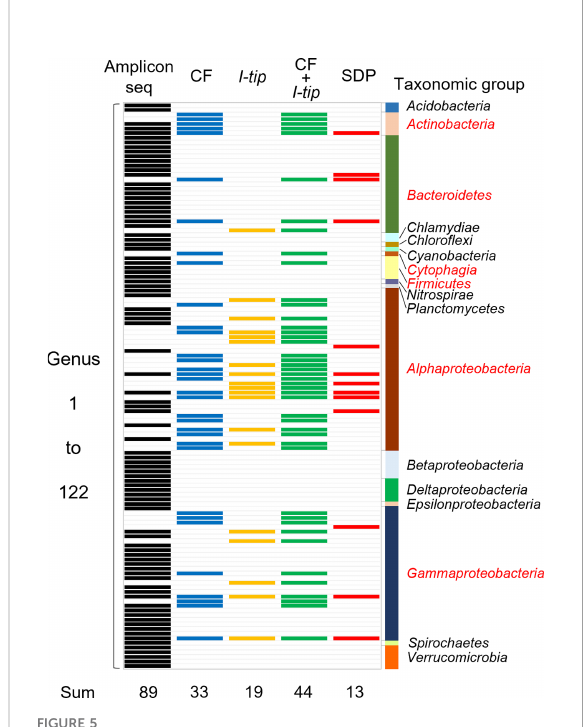
FIGURE 5 Band chart showing the comparison of microbial community compositions at the genera level among the sponge microbial community (amplicon sequencing data), isolates from CF, I-tip, and SDP cultivations. A total of 122 genera were detected from culture-independent and dependent approaches. Numbers at the bottom indicate number of genera detected with each method. Those are 89 from the amplicon sequencing data (black-colored bands), 33 from CF isolates (blue-colored bands), 19 from I-tip isolates (yellow-colored bands), 44 from sum of CF and I-tip isolates (green-colored bands), and 13 from SDP isolates (red-colored bands). Bar graph on the right indicates the taxonomic group to which those genera belong. The red letters for taxonomic group ’ s name represent the group that also isolated by the culture-dependent methods.